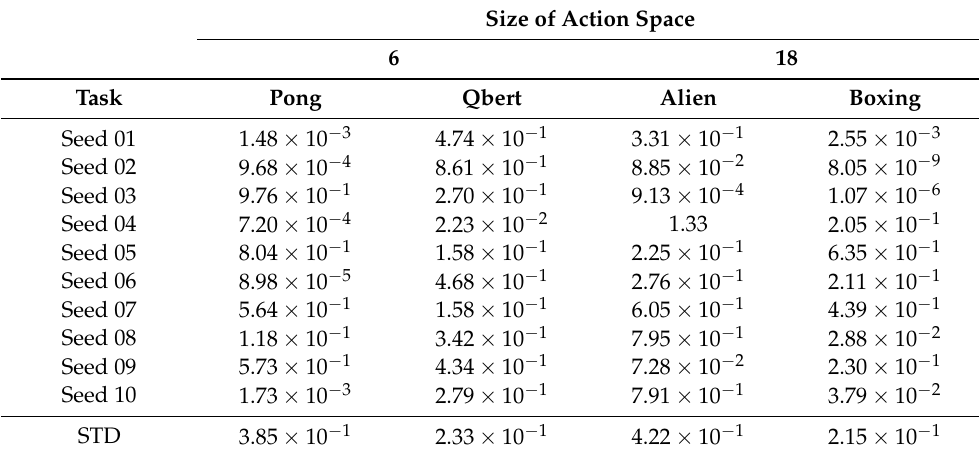
Table 1. Initial entropy of (Pong, Qbert) pair with action space size 6 and (Alien, Boxing) pair with action space size 18 under different random seeds, where “STD” denotes the standard deviation of the initial entropy values for 10 different random seeds.